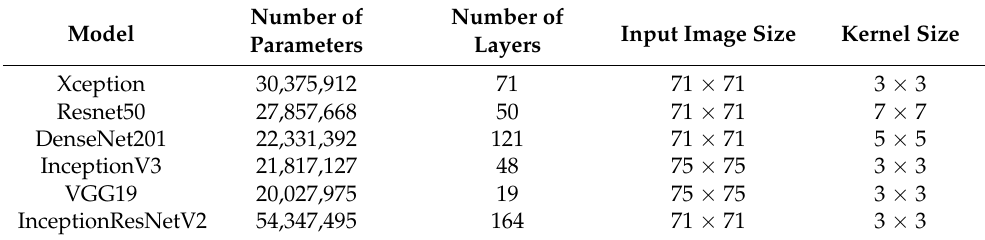
Table 2. Characteristics of the DL model architectures used in the experiments. Model